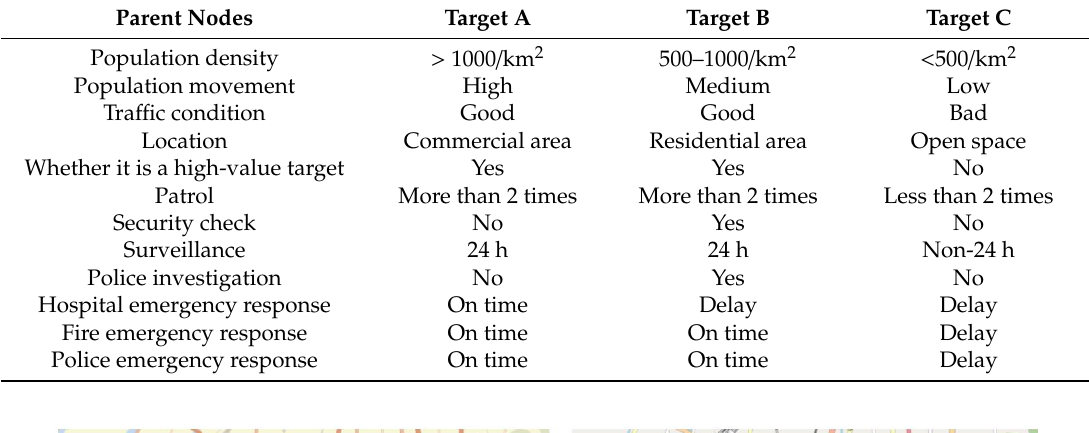
Table 7. Bayesian network node status at three locations.